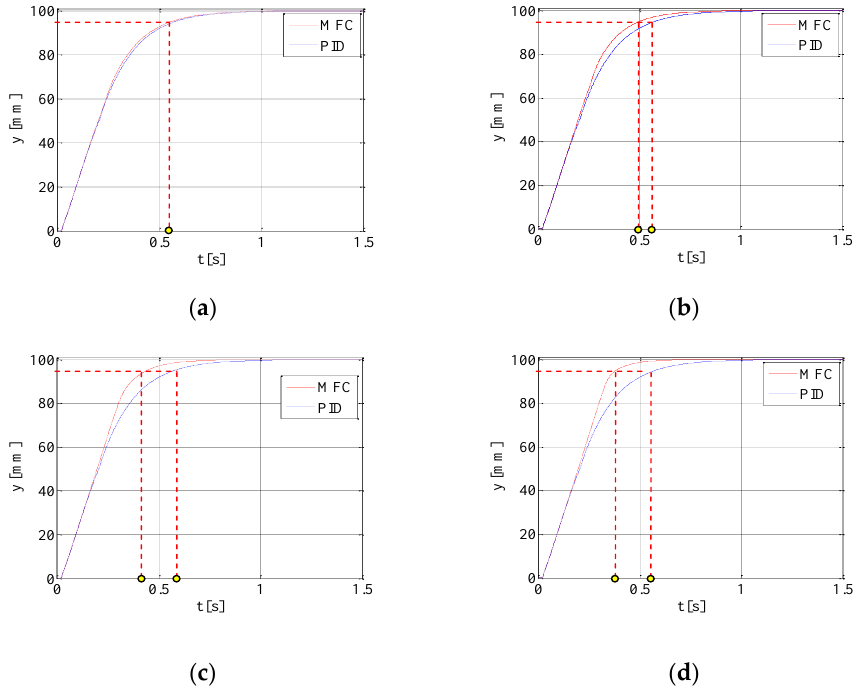
Figure 9. Comparison of PID and MFC step response for different k q_k parameters: ( a ) k q_k = 1, ( b ) k q_k = 1.2, ( c ) k q_k = 1.5, ( d ) k q_k = 2 ; F L = 1800 N.